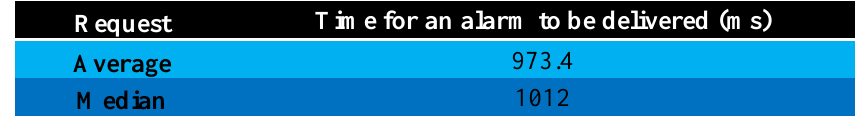
Table 10. Measures obtained to establish a ZephyrBT node - Bioharness